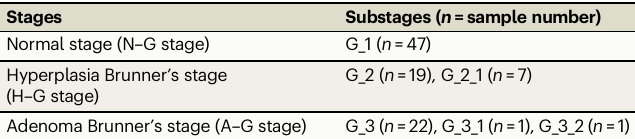
Table 3 | Subclassi fi cation information and the number of substage samples in the G subtype